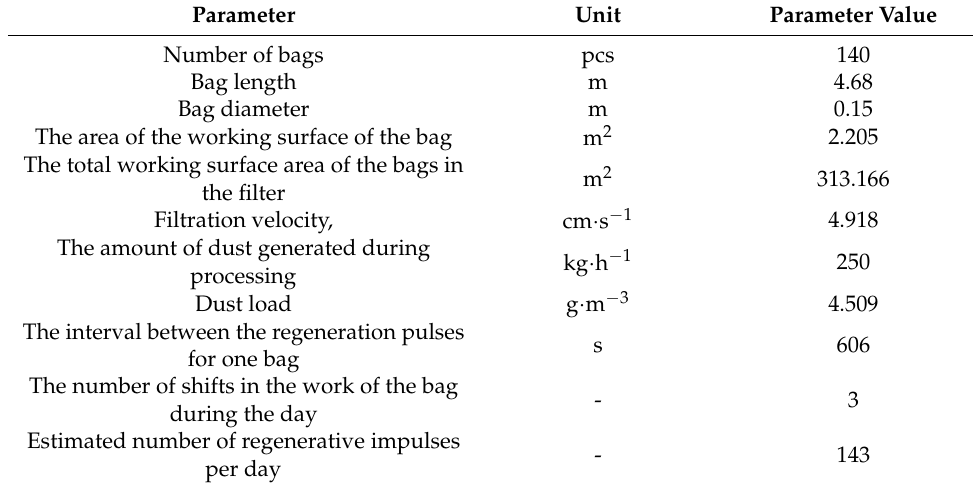
Table 2. Basic technical parameters of the filter